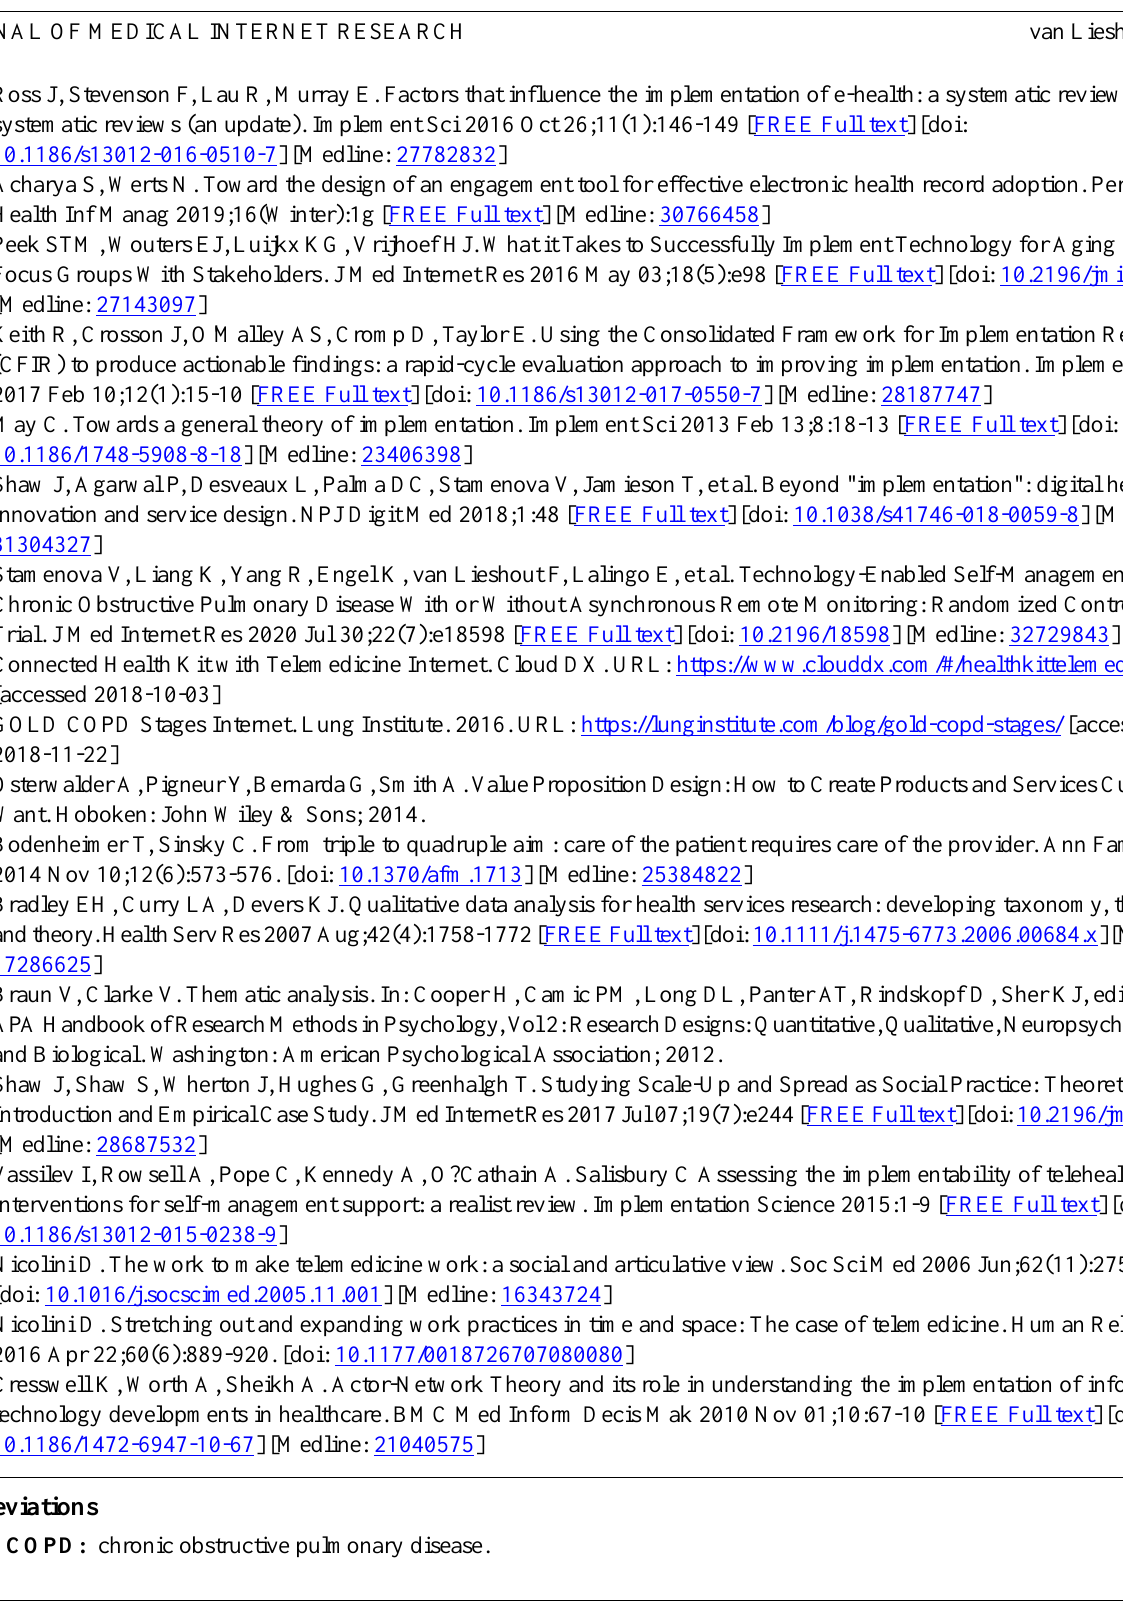
COPD: chronic obstructive pulmonary